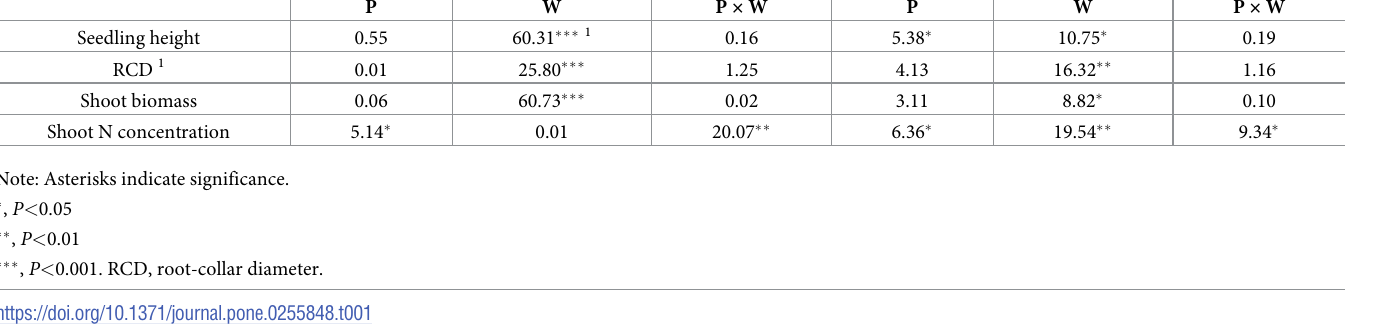
Table 1. F values from Analysis of variance (ANOVA) of nutrient distribution pattern (P), water condition (W), and their interaction (P × W) on growth, biomass, and nitrogen (N) concentration in shoots of birch ( Betula Platyphylla ) and larch ( Larix olgensis ) seedlings. Variables Birch Larch P W P × W P W P × W Seedling height 0.55 60.31 ��� 1 RCD 1 0.01 Shoot biomass 0.06 Shoot N concentration 5.14 � 0.01 Note: Asterisks indicate significance.